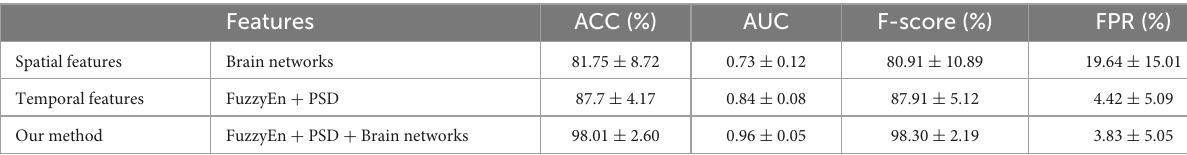
TABLE 5 Comparing the proposed spatiotemporal features method for seizure prediction to the temporal or spatial features method on the Kaggle dataset.